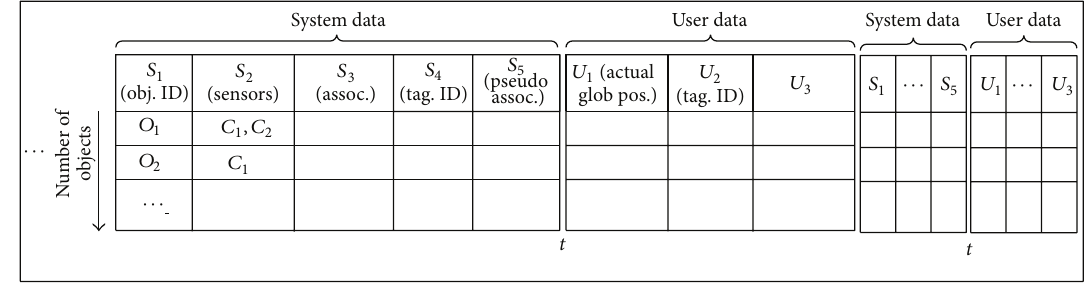
Figure 10: Information perspective